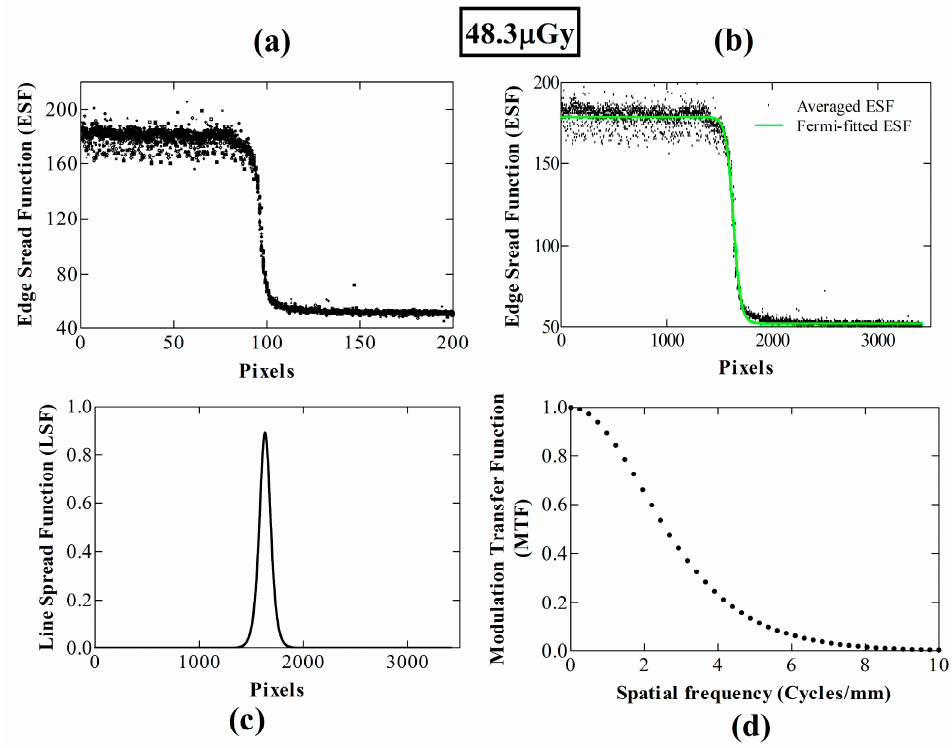
Figure 3. MTF calculation steps at an exposure level of 48.3 µ Gy, based on the IEC 2015; ( a ) all ESFs; ( b ) averaged and Fermi-fitted ESF; ( c ) LSF; ( d ) MTF.